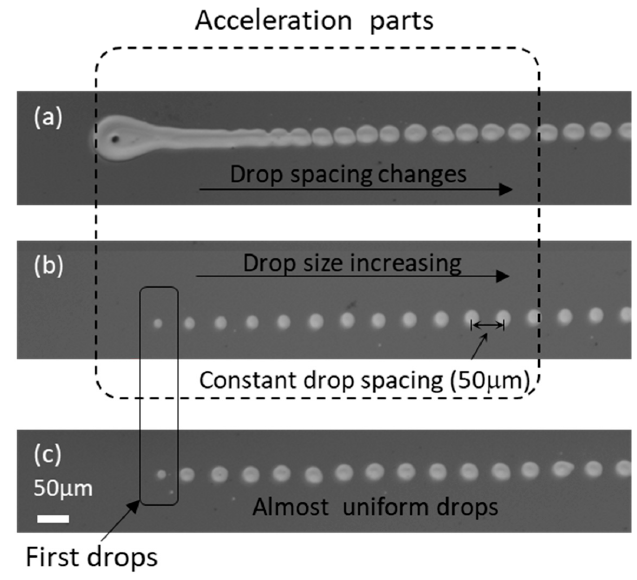
Figure 11. Jetting behavior due to different printing modes ( a ) Printing using conventional constant frequency jetting; ( b ) printing using the EPU including acceleration and deceleration; ( c ) printing using the EPU excluding acceleration and deceleration by using the dummy part.